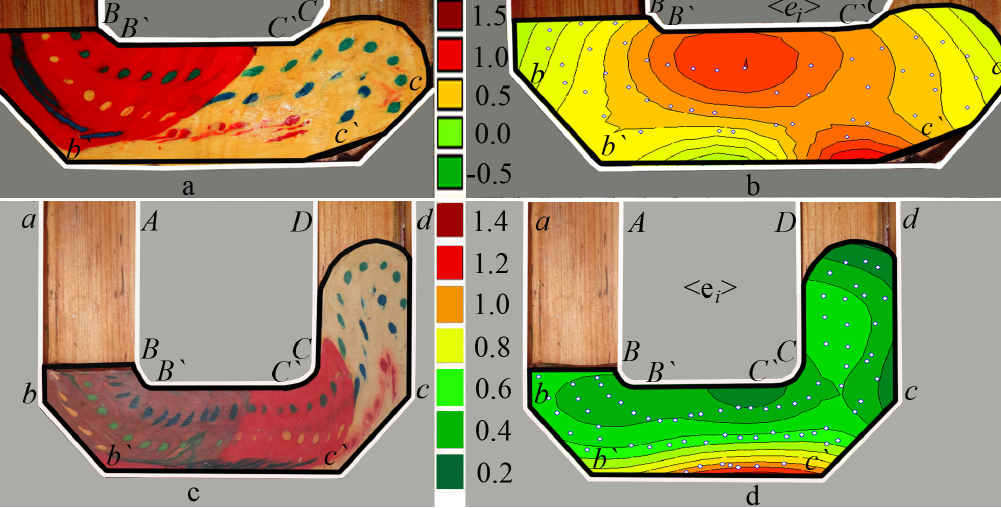
Fig. 2. ECMAE schemes of a truncated U-shaped die: (a, c) – soft workpiece models; (b, d) – the experimentally-theoretical fields of logarithmic strain intensities for the two- (a) and three- (c) component models (a,